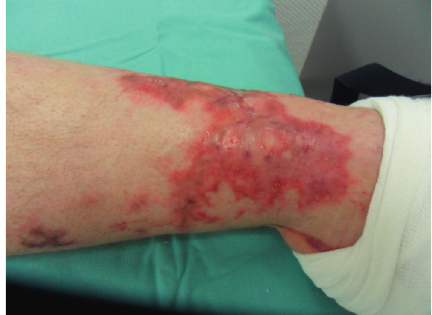
Figure 1: Residuum of tissue necrosis, anterior tibial margin, May 2016.